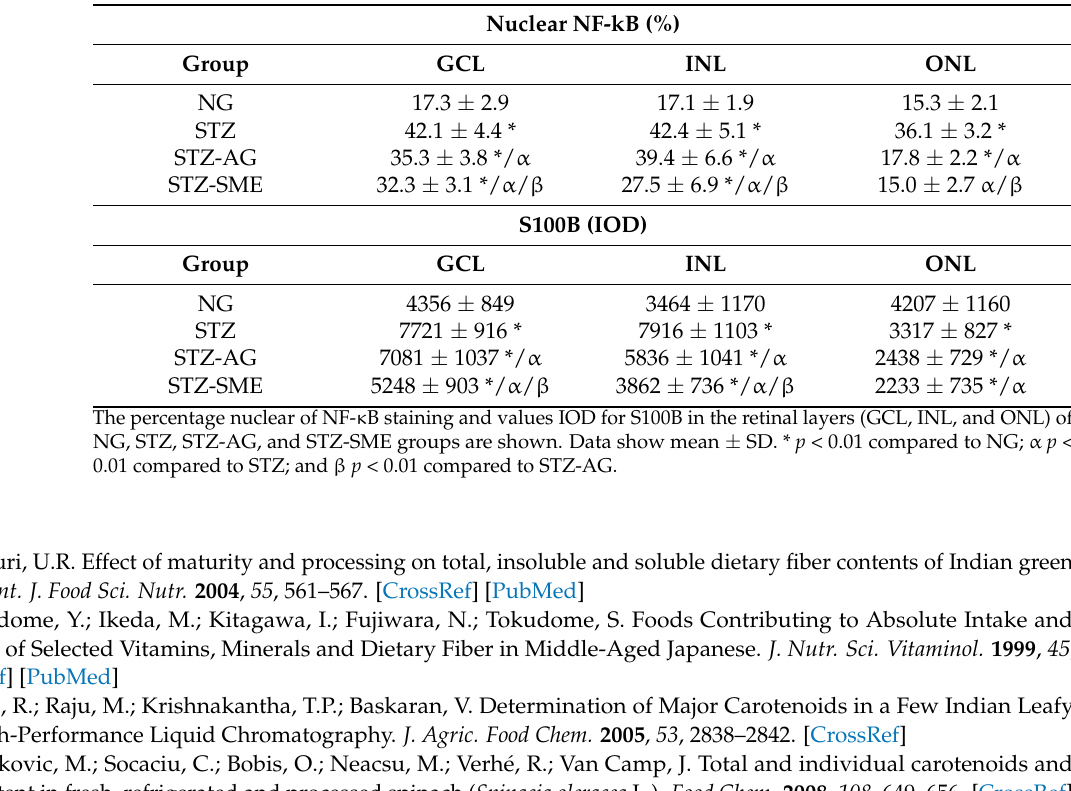
Table A3. Effect of SME on the retinal inflammation of STZ rats.